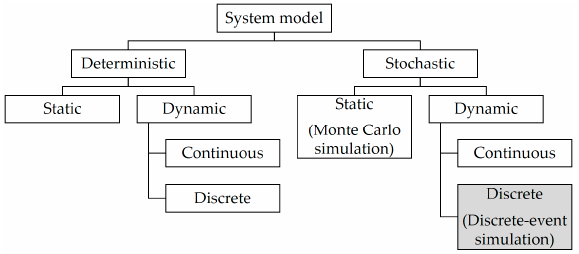
Figure 1. System model taxonomy (reproduced after [10]).